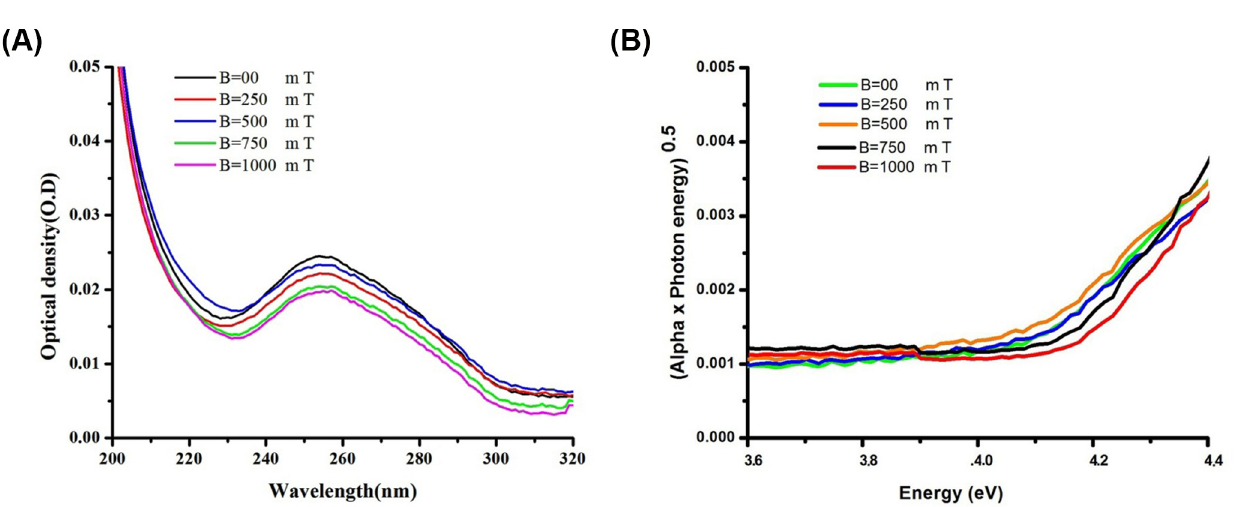
Fig 1. Absorption spectra and Band gap analysis of CG 100 . (A) The absorption spectra of diluted CG 100 exposed to a magnetic field were fitted by the equations for direct band-gap transitions and (B) the inset shows ( α E-photo) 2 versus photon energy for several magnetic fields for CG 100 oligonucleotide DNA.